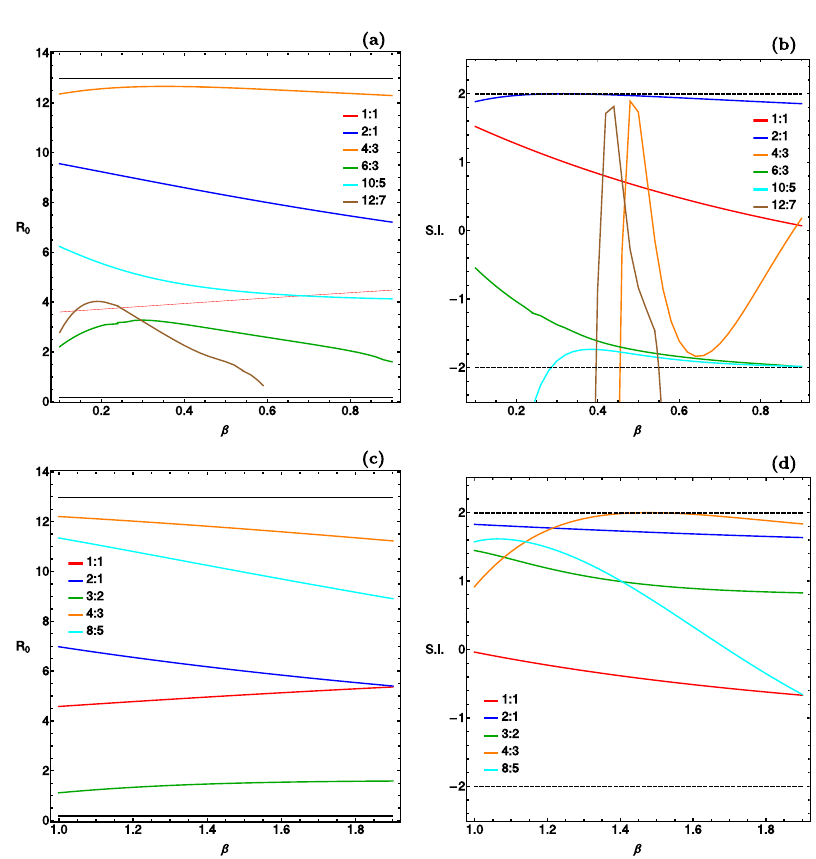
Fig. 7. Evolution of the R coordinate of periodic orbits as a function of the halo (cid:13)attening parameter (cid:12) for the PH models (panel a) and OH models (panel c), and the evolution of the stability index S.I. as function of (cid:12) for the PH models (panel b) and OH models (panel